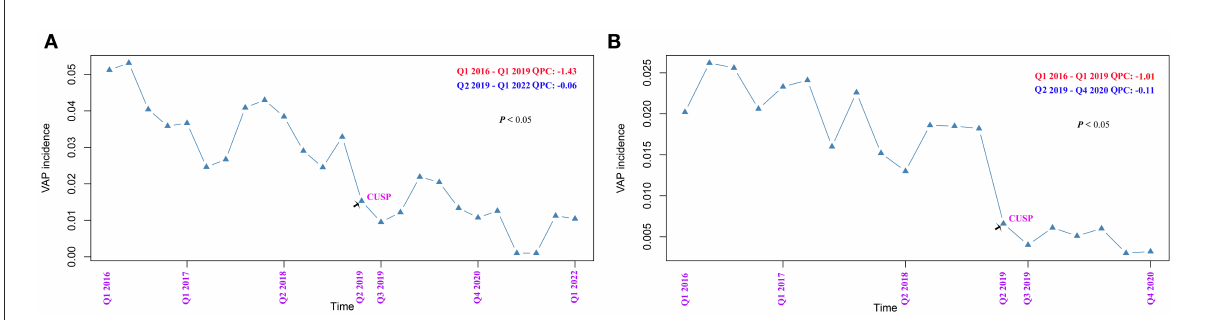
FIGURE1 Joinpoint regression analysis of the occurrence of ventilator-associated pneumonia (VAP) in TICU and SCIU settings by quarter. (A) TICU. (B) SICU. The asterisks indicate a statistical significance, P -value (* P < 0.05; ** P < 0.01; *** P < 0.001). TICU, transplantation intensive care unit; SICU, surgical intensive care unit; APC, annual percentage